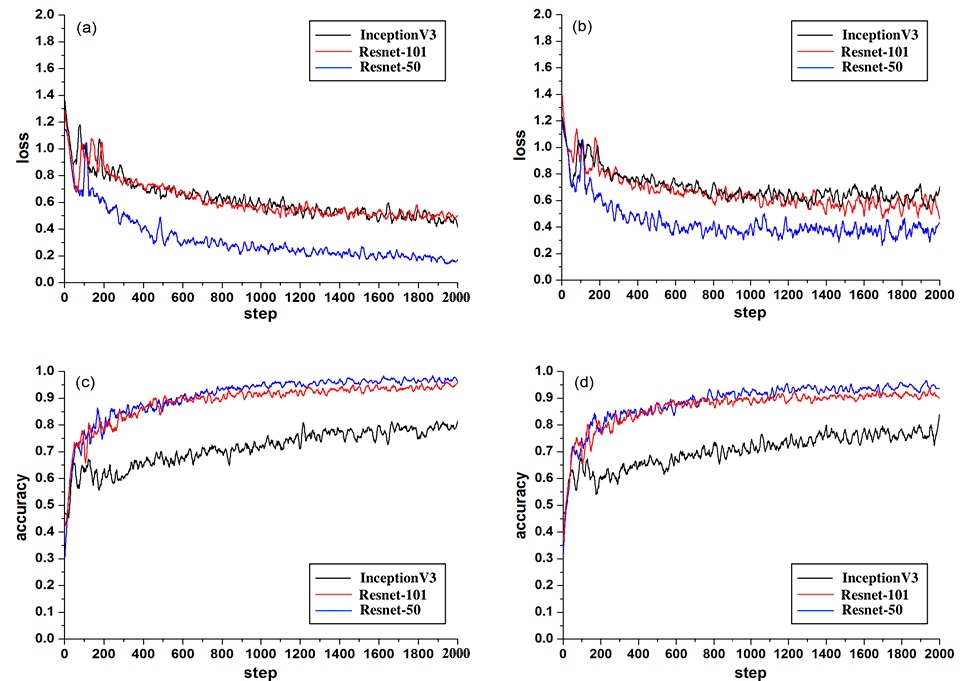
Figure 5. Comparison results of Loss and Accuracy during training and testing for Inception V3, Resnet-101, and Resnet-50: ( a ) is the training loss, ( b ) is the testing loss, ( c ) is the training accuracy, and ( d ) is the testing accuracy.